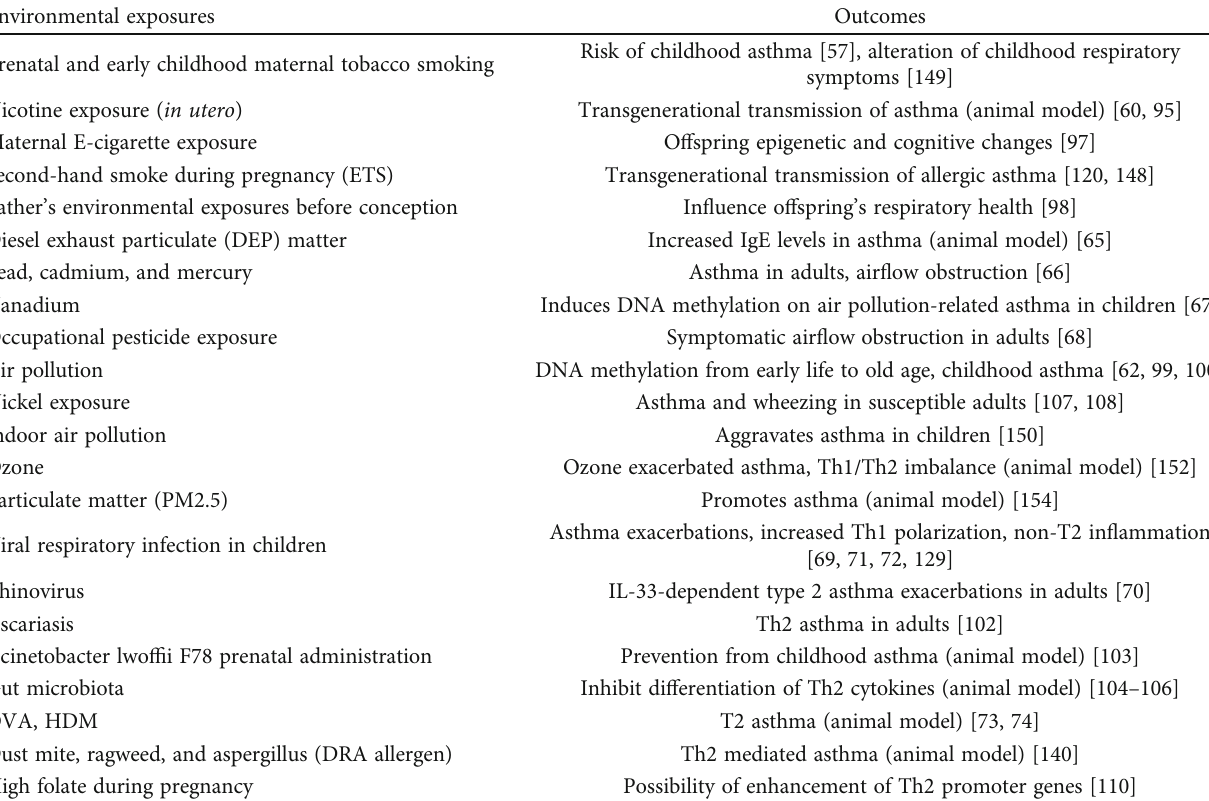
Table 4: Environmental exposures and respiratory outcomes in